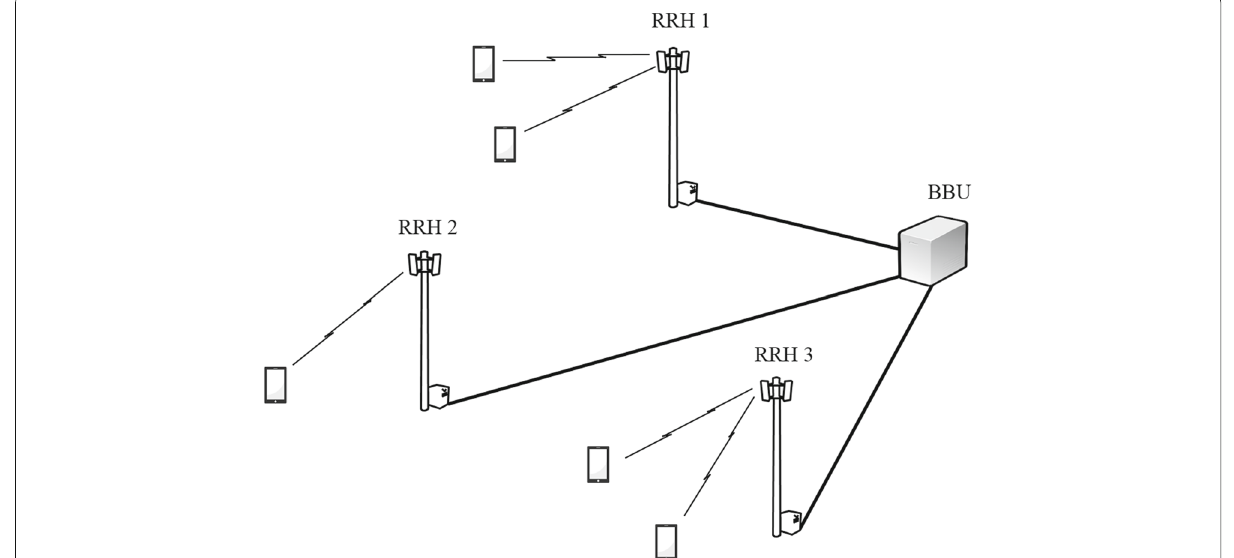
Fig. 1 The CRAN architecture for 5G